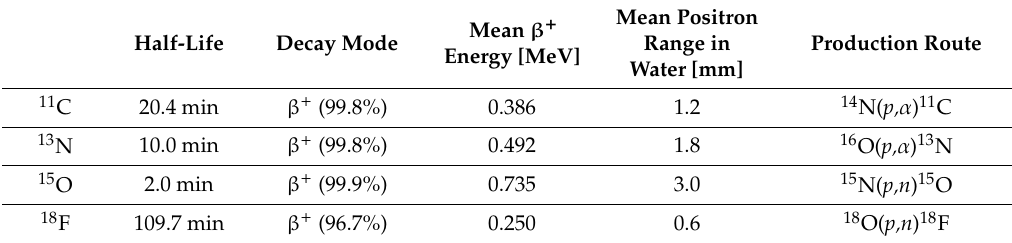
Table 2. Radioisotopes for PET imaging . Adapted from Conti and Eriksson [172], Holland et al. [181], and Berger et al.